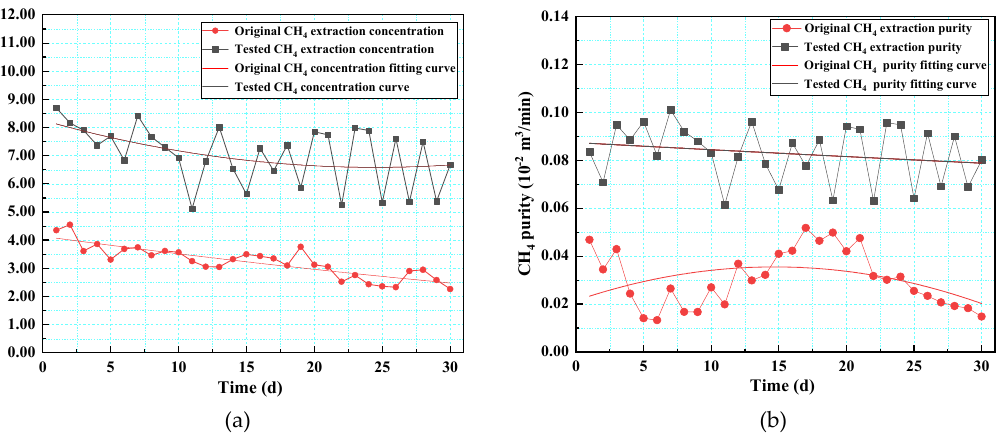
Figure 12. Average gas drainage concentration and drainage purity during medium-pressure injection ( a ) Average gas drainage concentration and ( b ) Average gas drainage purity.